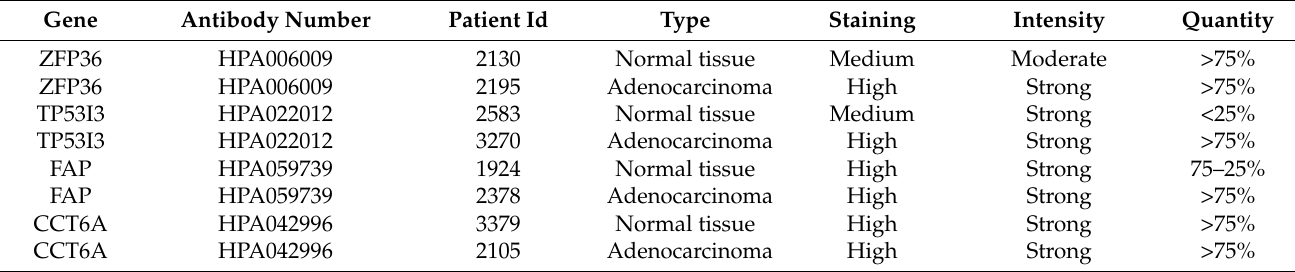
Table 2. HPA Patient